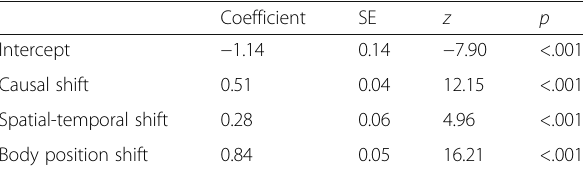
Table 4 Results from logistic mixed effects model using situational analysis variables